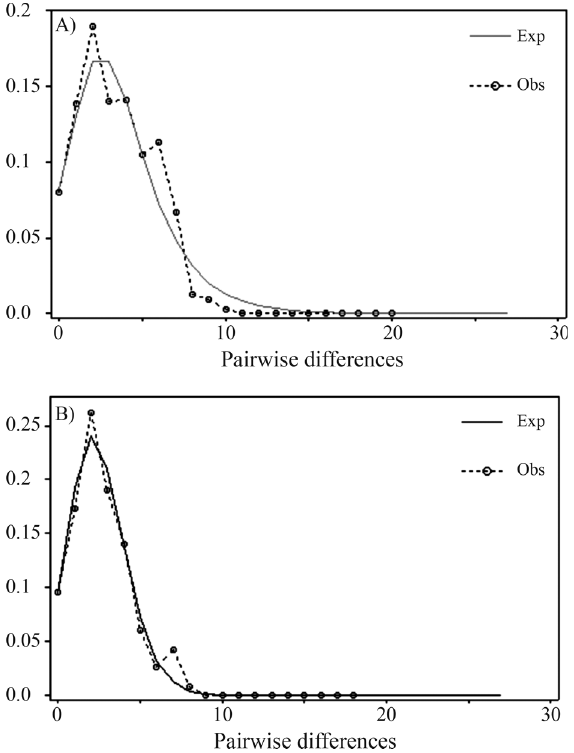
Figure 3 - Graphs depicting the results of the Mismatch Distribution anal- ysis for the total sample (A) and South American samples alone (B). The analysis was performed with 669 bp of P. concolor ND5 sequences (ex- cluding all sites with missing information or gaps). The dashed line repre- sentstheobservedpattern,whilethecontinuouslinedepictsthepatternex- pected under a model of sudden demographic